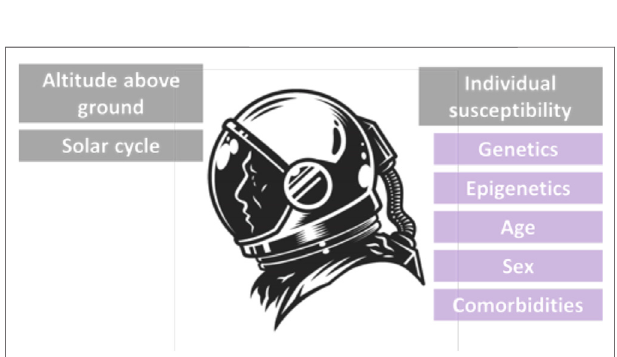
FIGURE 4 | The environmental, physical and individual factors affecting radiation susceptibility of astronauts.